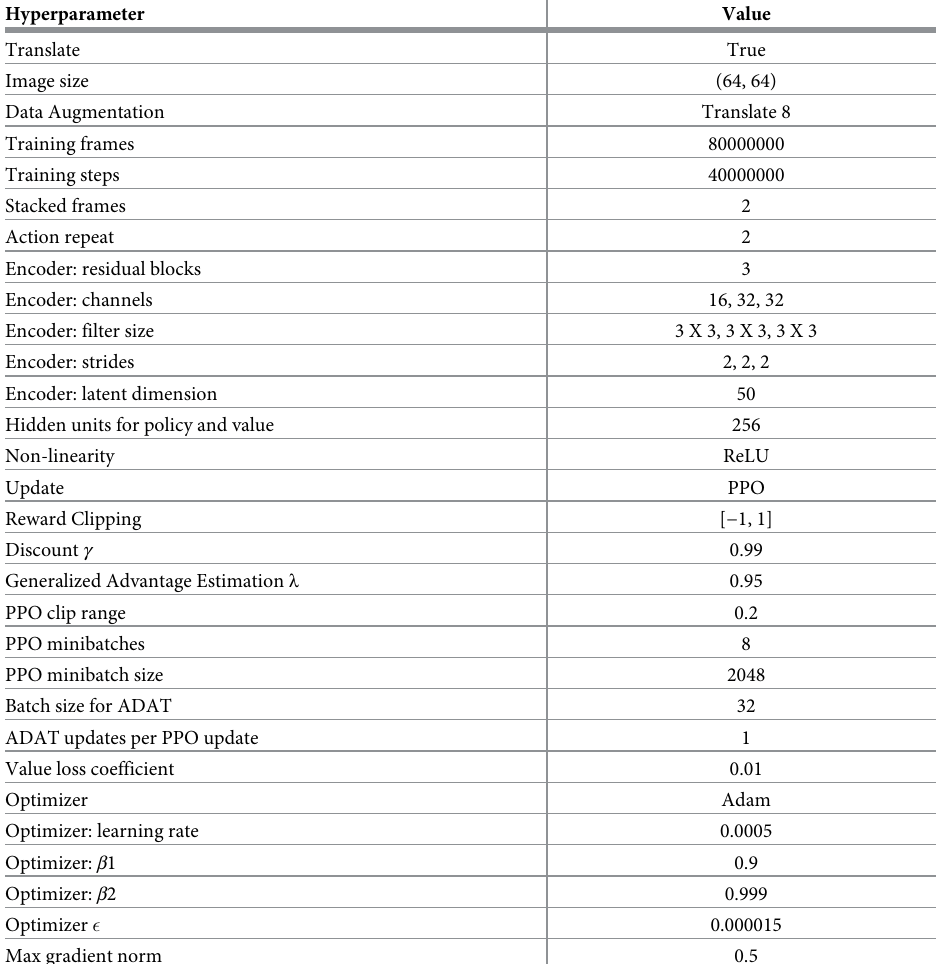
Table 2. Hyperparameters for OpenAI